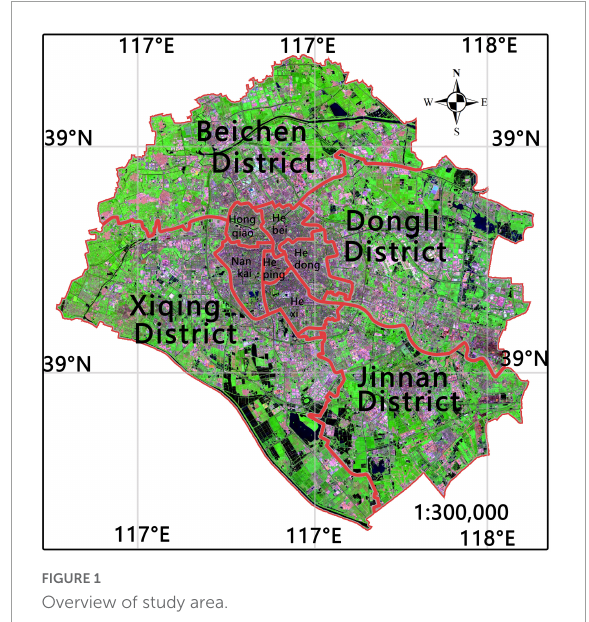
FIGURE1 Overview of study